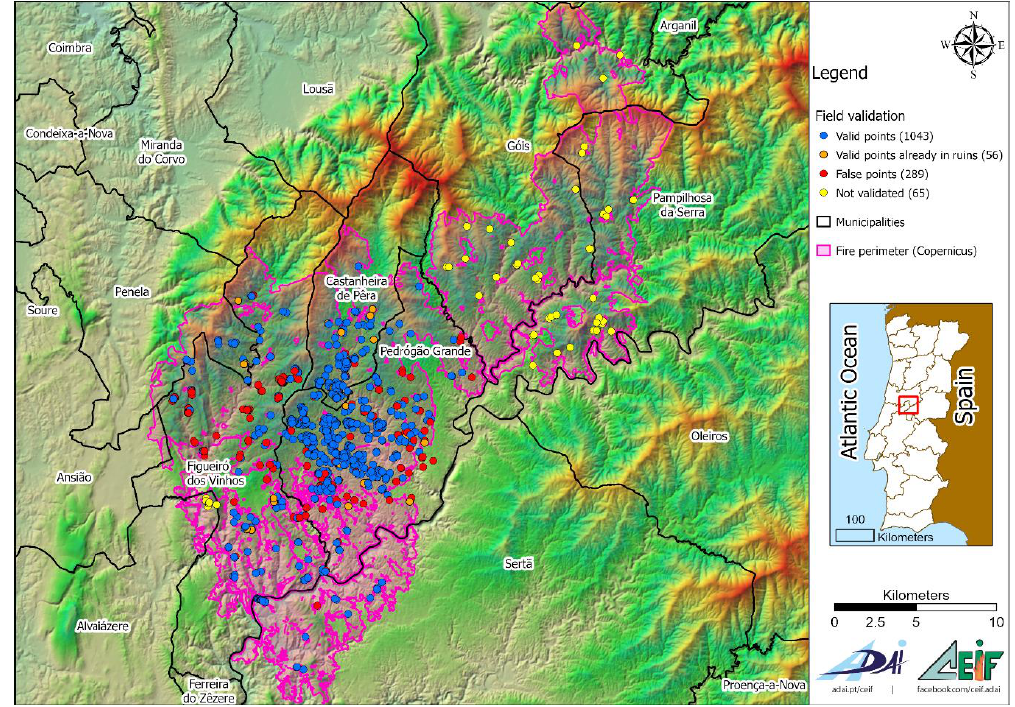
Figure 3. Location of all points visited (blue, red, and orange) and not visited (yellow).